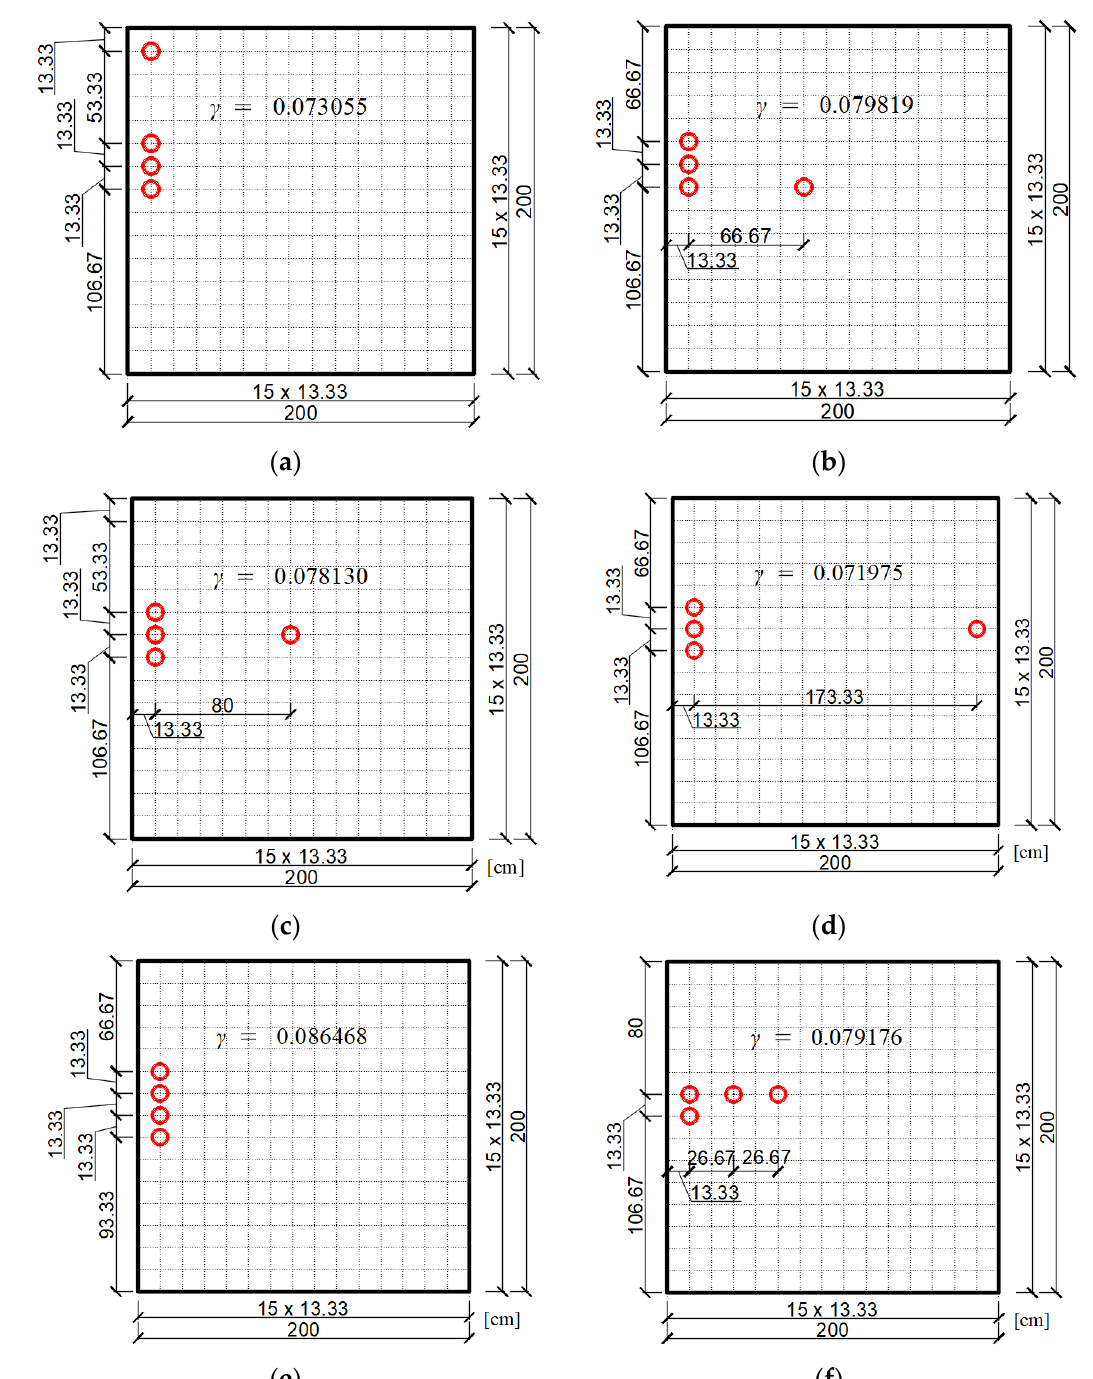
Figure 9. Optimal position of a group of four dampers according to the PSO algorithm for two initially adopted neighborhoods: ( a ) Neighborhood 1 for draw 1; ( b ) Neighborhood 2 for draw 1; ( c ) Neighborhood 1 for draw 2; ( d ) Neighborhood 2 for draw 2; ( e ) Neighborhood 1 for draw 3; ( f ) Neighborhood 2 for draw 3.